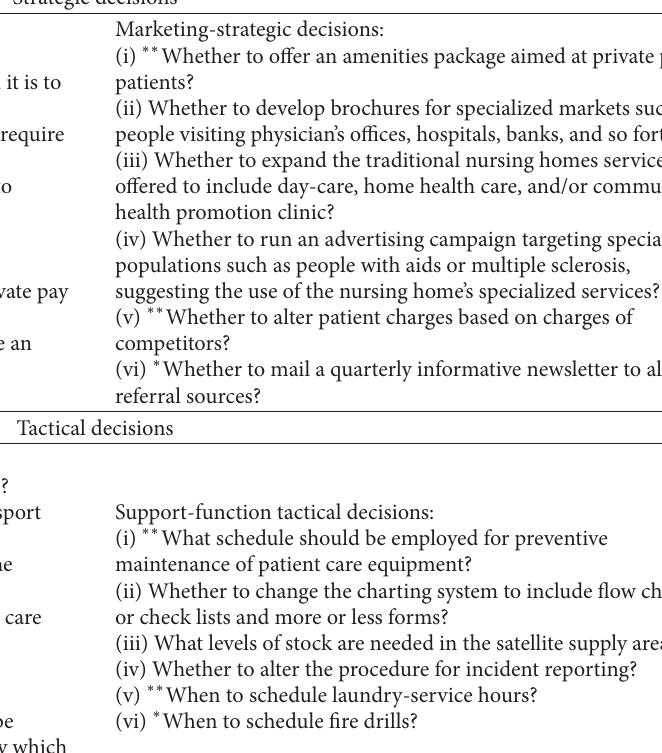
Table 5: Decisions included in the participation in decision-making instrument. Strategic